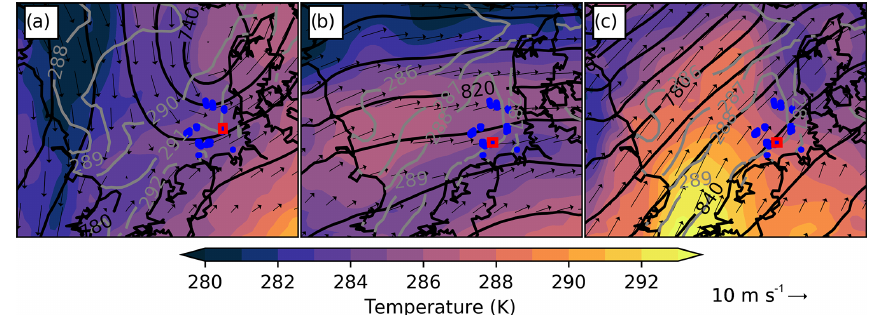
Figure 5. ERA5 reanalysis data: temperature (colored contours; K) and geopotential height (20m increments) as black contour lines at 925hPa for the three case studies as listed in Table 1, at 15:00UTC on 9 August 2017, at 15:00UTC on 14 October 2017 and at 09:00UTC on 15 October 2017 (Table 1). The gray solid contour lines show the SST.